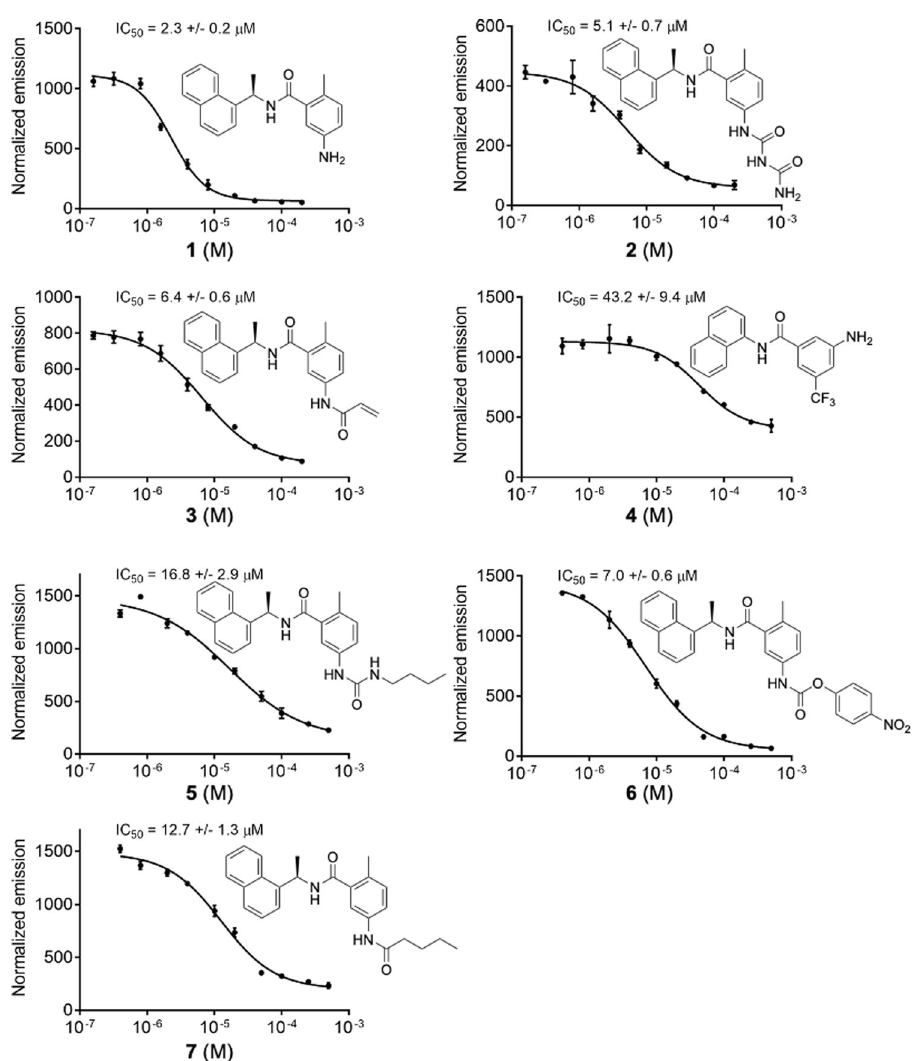
Fig. 2 Biochemical activity assays for compounds 1 – 7. Activity assays were performed using substrate shown in Supplementary Fig. 3. Error bars represent the standard error of the mean for n = 3